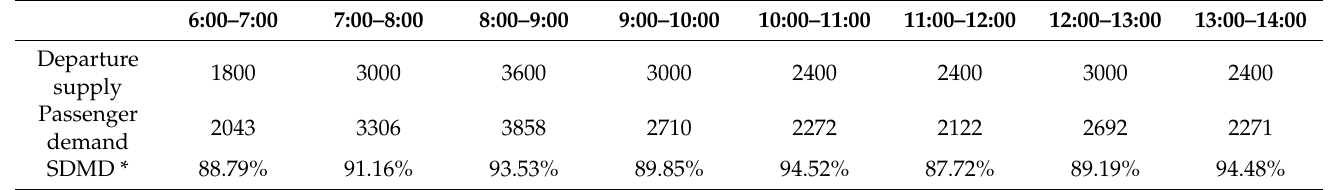
Table 18. Details of supply and demand matching degree of multi-cycle timetable of intercity